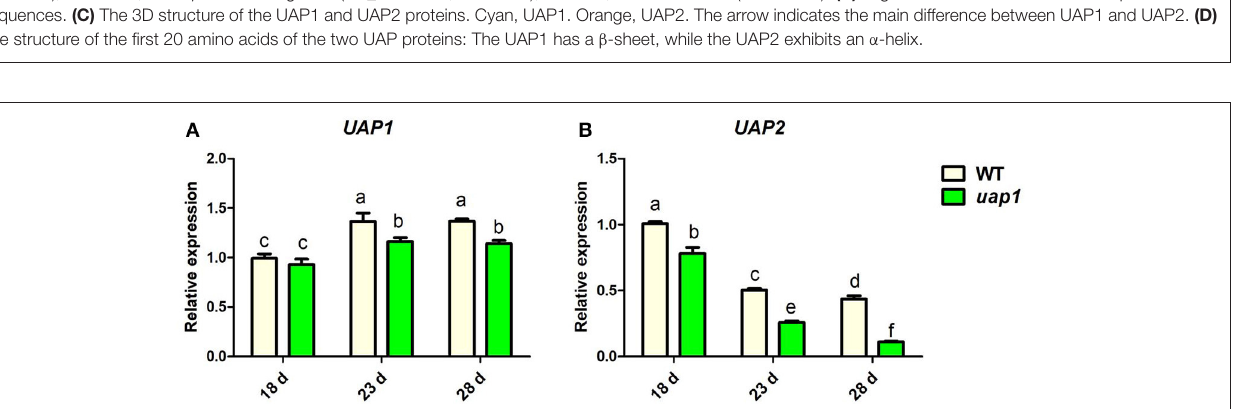
FIGURE 2 | (XP_022925908.1); CmUAP2, Cucurbita moschata (XP_022926514.1); AtUAP1, Arabidopsis thaliana (NP_564372.3); AlUAP1 Arabidopsis lyrate (XP_020870296.1); AtUAP2, Arabidopsis thaliana (NP_181047.1); AlUAP2, Arabidopsis lyrate (XP_002879530.1); OsUAP1, Oryza sativa (XP_015650402.1); BdUAP1, Brachypodium distachyon (XP_010234461.1); SiUAP1, Setaria italica (XP_004972591.1); ZmUAP1, Zea mays (PWZ43849.1); SbUAP1, Sorghum bicolor (XP_002444024.1); OsUAP2, Oryza sativa (XP_015633457.1); BdUAP2, Brachypodium distachyon (XP_003580539.1); SiUAP2, Setaria italica (XP_004976790.1); ZmUAP2, Zea mays (ONM14001.1); SbUAP2, Sorghum bicolor (XP_021317962.1); CeUAP, Caenorhabditis elegans (NP_497777.1); ScUAP, Saccharomyces cerevisiae (NP_010180.1); AfUAP, Aspergillus fumigatus , (XP_746714.1); MsUAPA, Mus musculus (NP_001291975.1, isoform A); MsUAPB, Mus musculus (NP_001291974.1, isoform B); HsUAPA, Homo sapiens (NP_001311044.1, isoform A); HsUAPB, Homo sapiens (NP_001311045.1, isoform B); LdUAP1, Leptinotarsa decemlineata (XP_023024179.1); LdUAP2, Leptinotarsa decemlineata (XP_023022882.1); TcUAP1, Tribolium castaneum (NP_001164533.1); TcUAP2, Tribolium castaneum (NP_001164534.1); AmUAP, Apis mellifera (XP_624349.1); NvUAP, Nasonia vitripennis (XP_001602623.1); BmUAP, Bombyx mori (AIQ85099.1); AgUAP, Anopheles gambiae (XP_317600.4); ApUAP, Acyrthosiphon pisum (XP_001944680.1); LmUAP1, Locusta migratoria (AGN56418.1); LmUAP2, Locusta